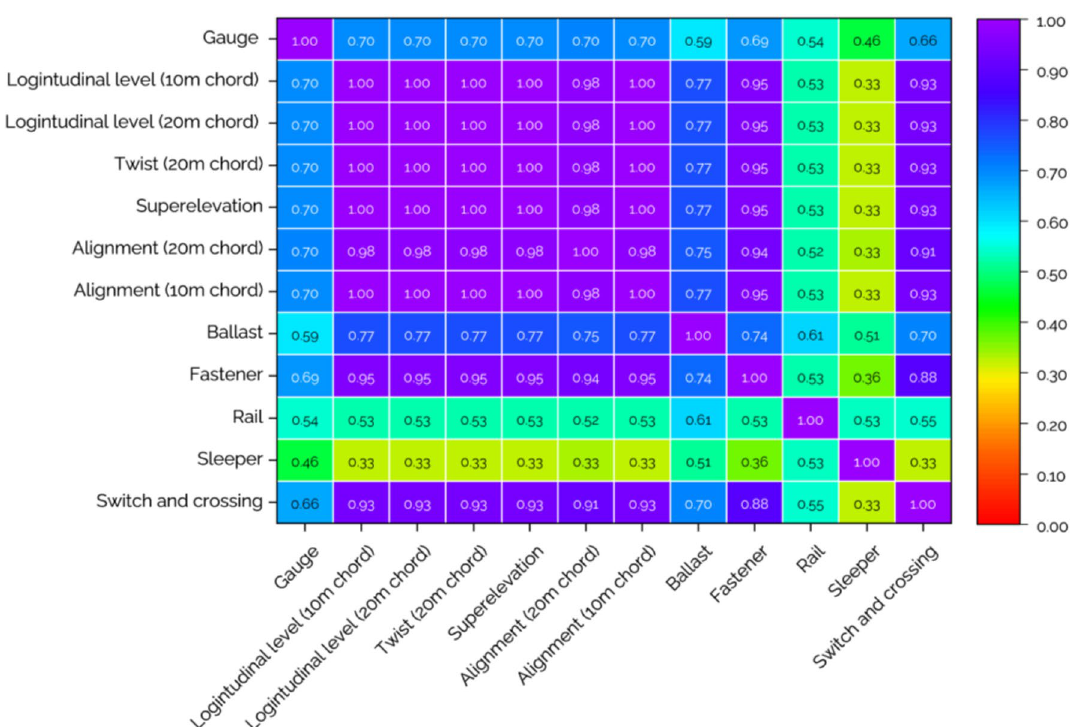
Figure 3. Correlation between